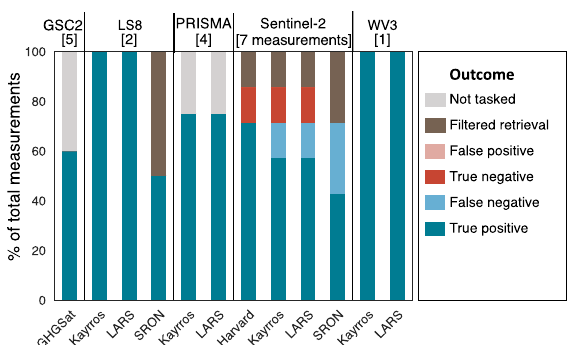
Figure 1. Detection performance by satellite and team. Total number of measurements listed in brackets. For each satellite, most teams correctly detected most emissions as true positives or true negatives (correctly identified non-emissions). In some cases, e.g. two GHGSat-C2 (GSC2) overpasses, the satellite was not tasked and collected no data. In others, e.g. one SRON retrieval of Landsat 8 (LS8), no retrieval was attempted due